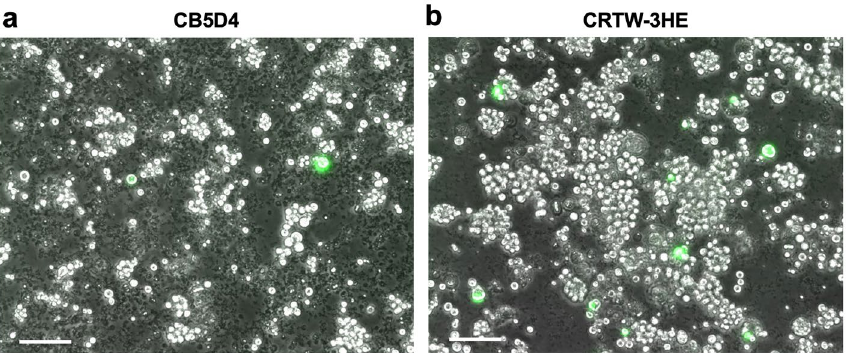
Figure 2. Differences in cell damage between cell strains. 10 × 10 6 cells were electroporated with 5 µg of the plasmid by 175V × 5 pulses. Images were taken three days after the transfection. Merge images of GFP and bright field are shown. The white and spherical objects observed indicate living cells. Other objects observed as small, black shadows indicate cellular debris. Many cell debris can be observed in the CB5D4 strain ( a ), whereas very few were observed in the CRTW-3HE strain ( b ). The scale bars; 50 µm.